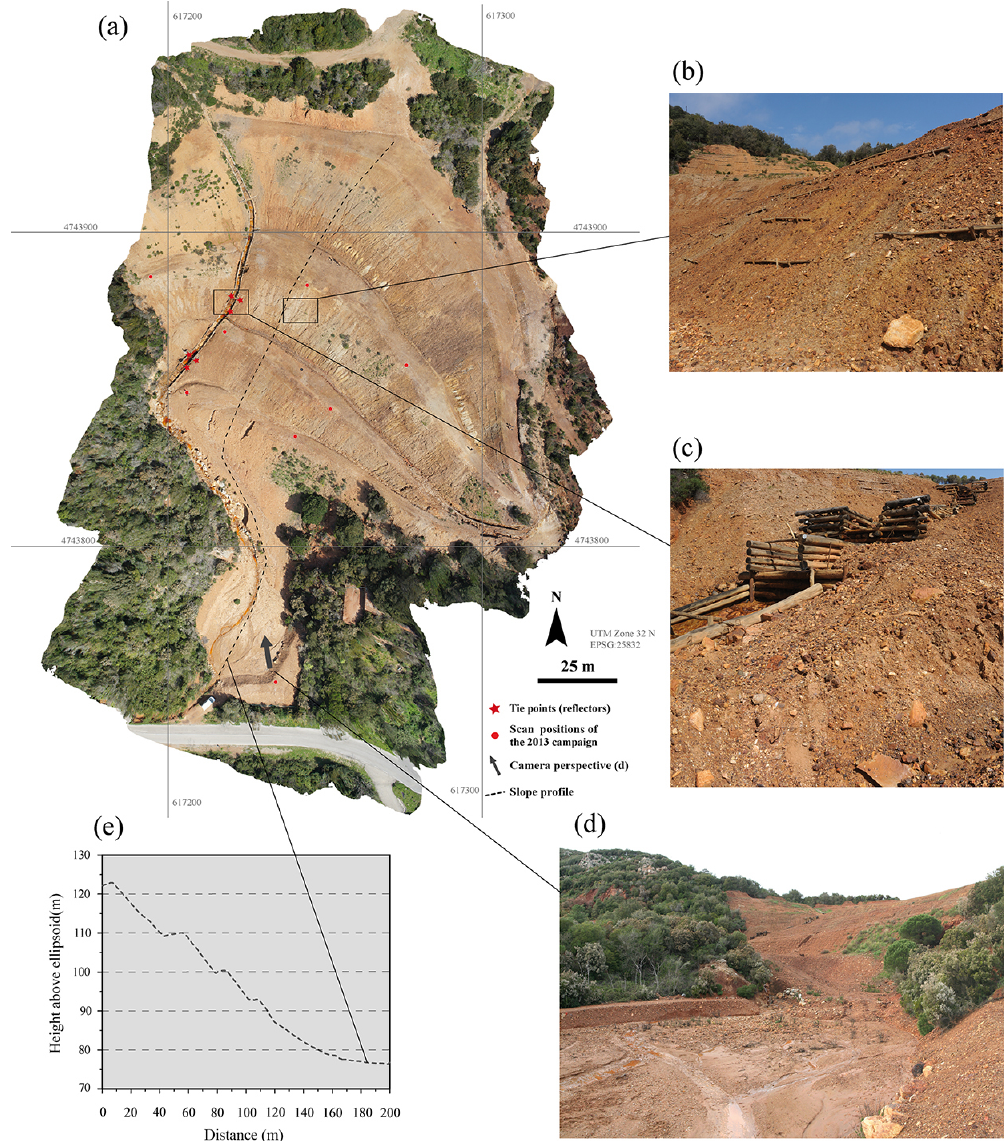
Figure 2. (a) Orthorectified and referenced aerial photograph (by the 2013 UAV campaign, ground resolution 5cm) of the investigated slope with the 2013 scanning positions, (b) the artificial barriers on the slope, (c) a part of the main artificial drainage channel, (d) photograph of the slope and part of the reservoir, and (e) profiles of the artificial slope and the main artificial drainage channel.